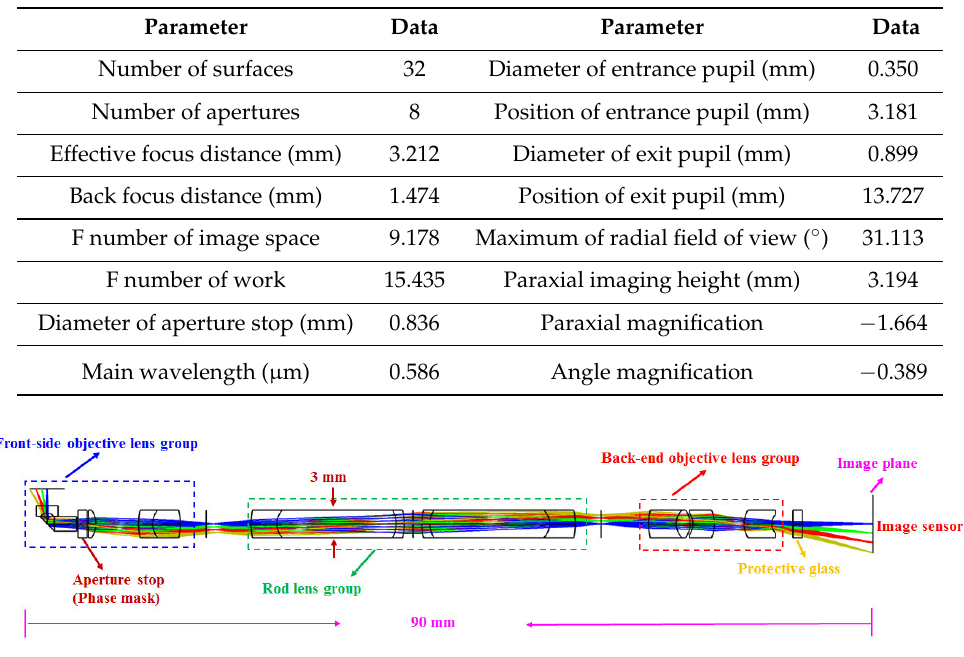
Figure 1. Designed model of optical endoscope. The length and diameter of optical endoscope are 90 mm and 3 mm, respectively. The effective focal length ( f (cid:48) ), the diameter of entrance pupil ( D p ), the diameter of aperture stop ( D a ) and objective distance ( d o ) are 3.21 mm, 0.35 mm, 0.836 mm and 2 mm, respectively. The phase mask will be placed at the aperture stop when aiming at extending the depth of field